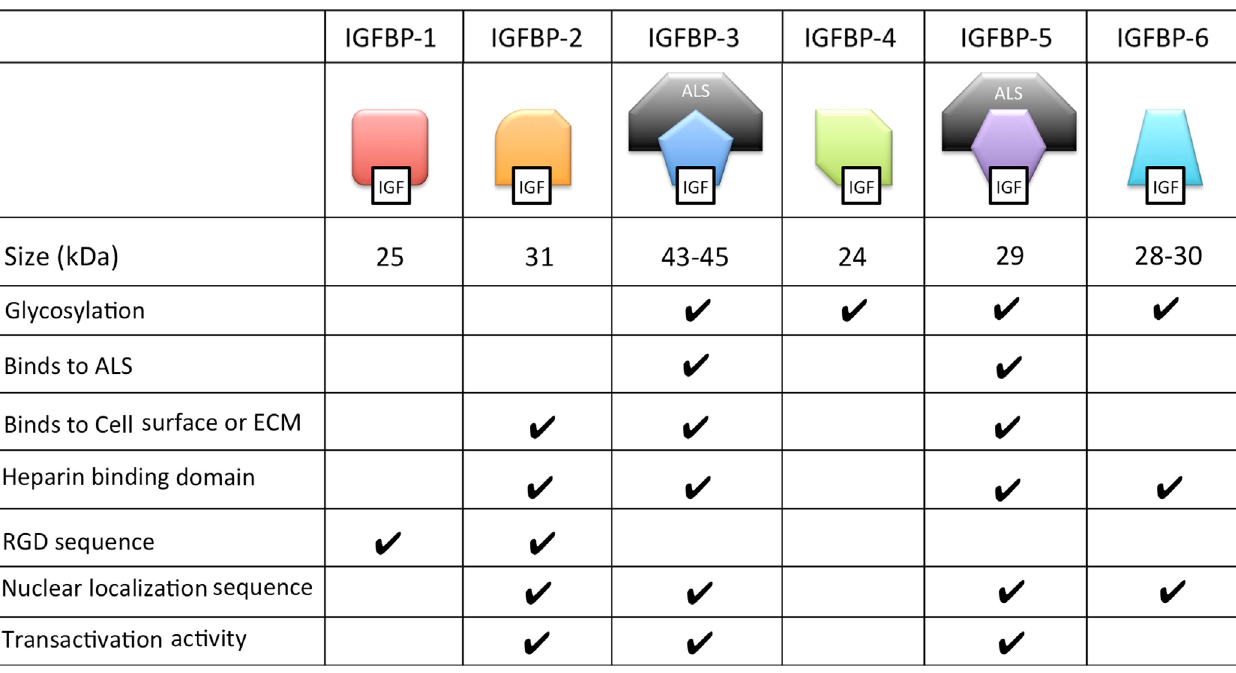
TABle 2 | Structural and biochemical characteristics of the six distinct types of